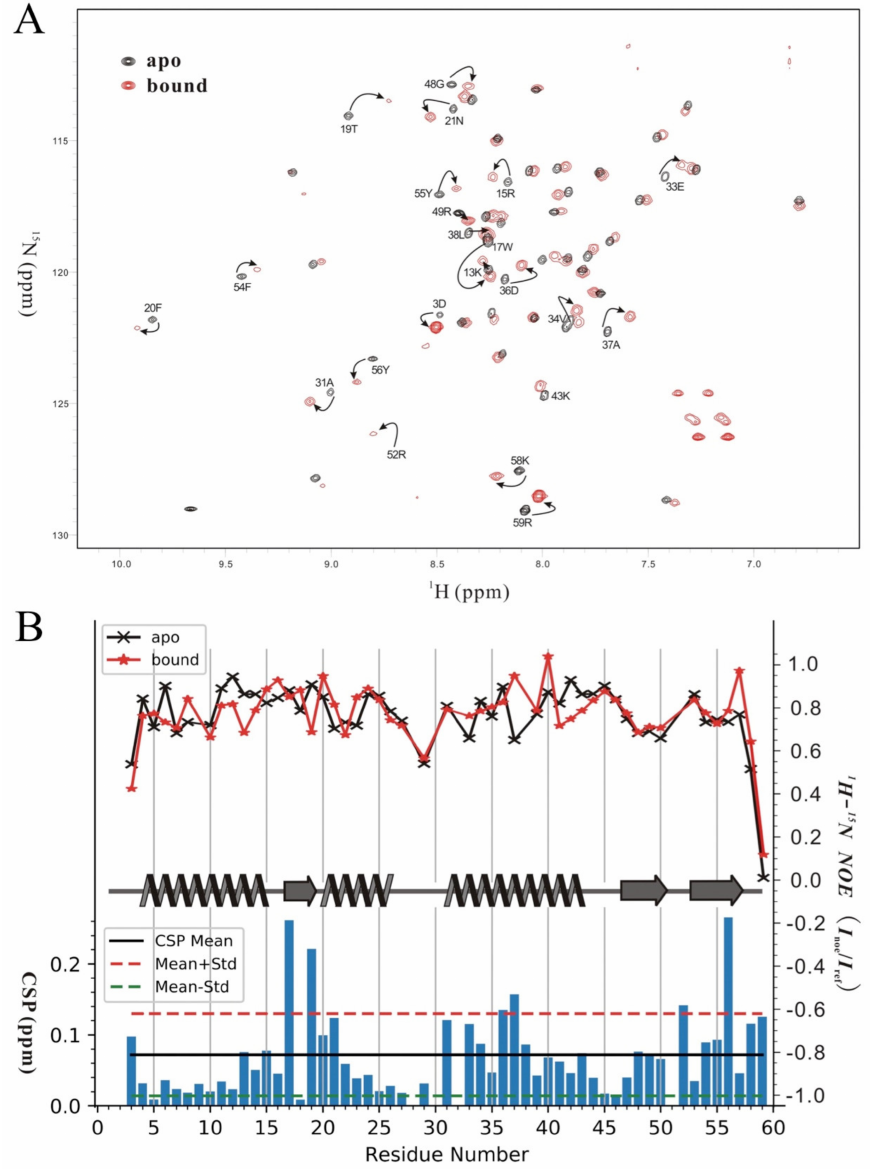
Figure 5. NMR CSP analysis of Sul7s upon ssDNA binding. ( A ) Overlaid 1 H- 15 N HSQC spectra of apo (in black) and bound (in red) states of Sul7s. ( B ) Chemical shift perturbations (lower part) and 1 H- 15 N hetero-nuclear NOE (upper part) versus residue numbers. The mean value of all residues’ CSP is drawn in black solid line, and CSP+Std and CSP-Std values are drawn in red and blue dashed lines. In the hetero-nuclear NOE plot, the symbols and lines for the apo and bound form of Sul7s are drawn in black and red colors, respectively. The secondary structures of Sul7s are shown in the